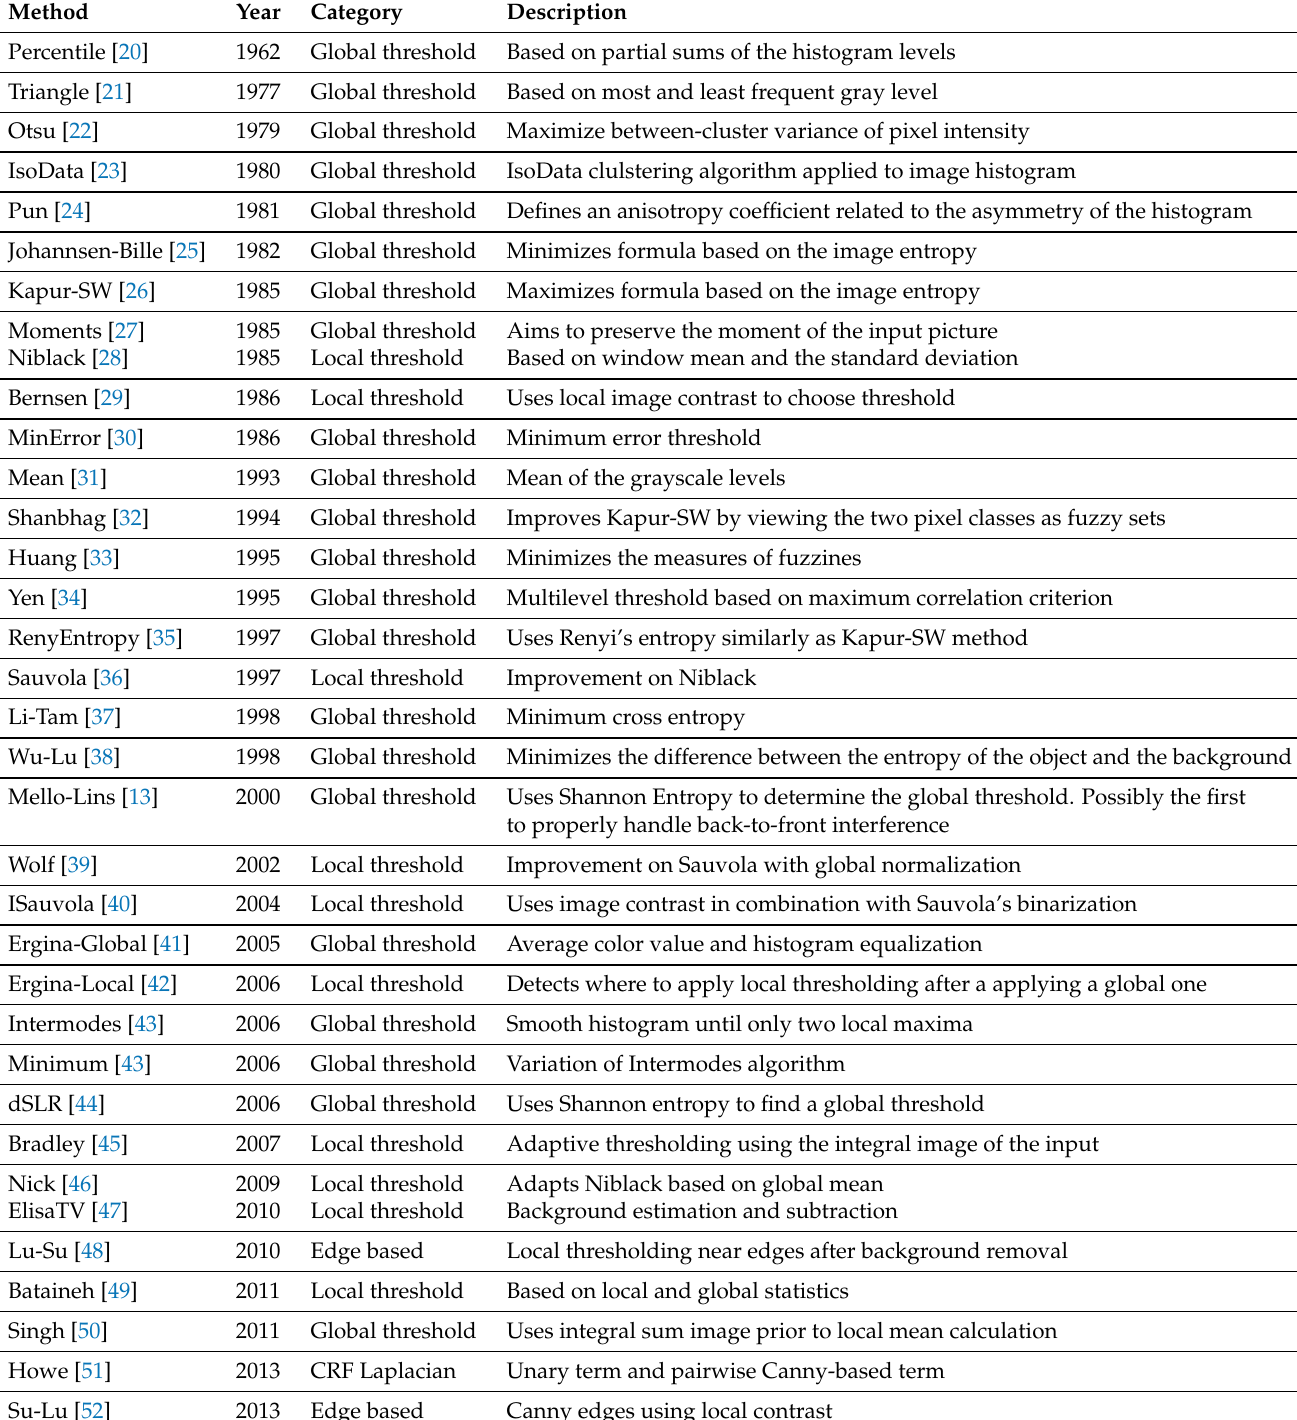
Table 2. Tested binarization